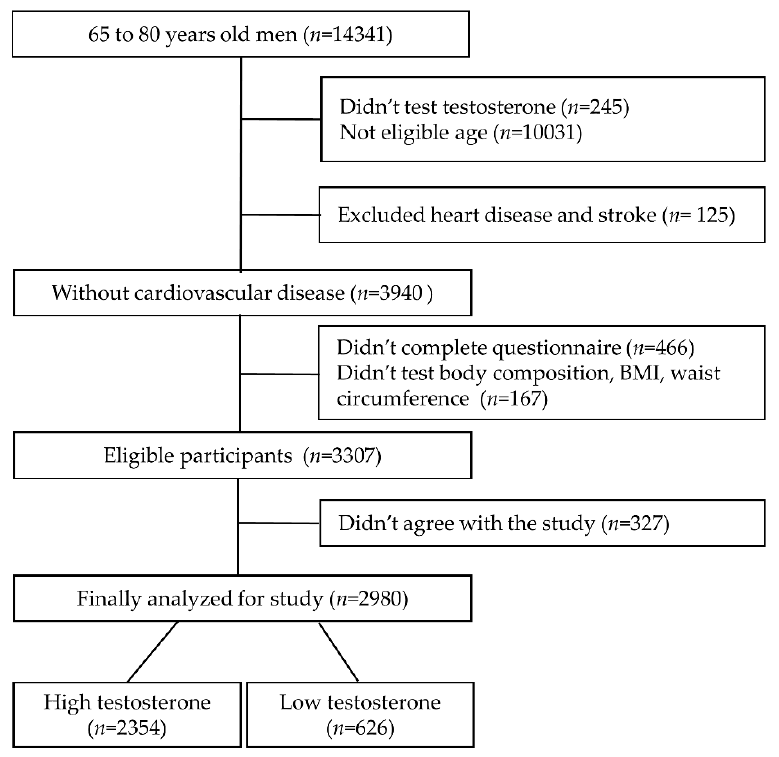
Figure 1. Participant’s inclusion and exclusion criteria diagram.